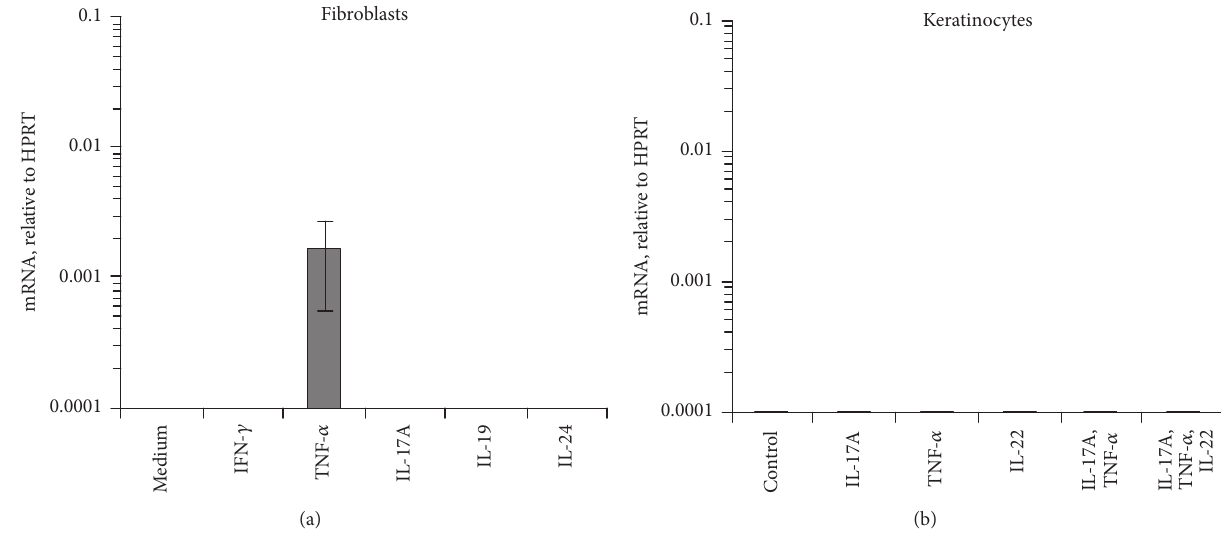
Figure 3: Activated fibroblasts but not keratinocytes express MMP8. Primary human dermal fibroblasts (a) and keratinocytes (b) were treated with AI-relevant cytokines as indicated or were left unstimulated (control). Expression was analyzed by RT-qPCR. Data from 3 experiments are shown (mean ±